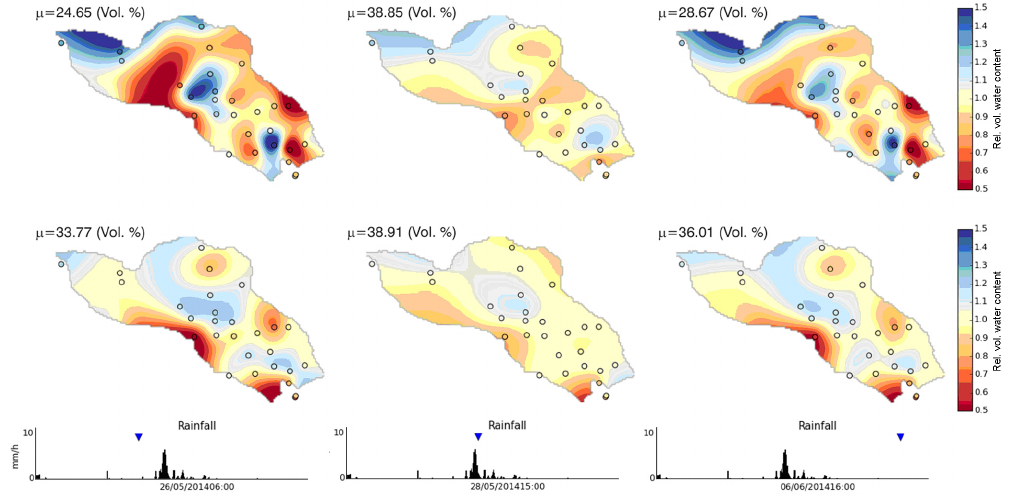
Figure 12. Hypothesis testing example 3: soil moisture patterns scaled by the mean catchment soil moisture µ before, during and after an event in May 2014. Top and bottom panels show 5 and 20cm soil moisture, respectively. Circles show measurement locations, patterns are interpolations. Time series at the very bottom show rainfall with the time of the soil moisture patterns indicated by blue triangles.